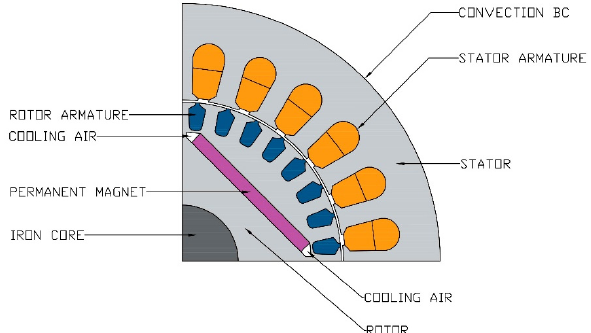
Figure 14. Quarter section of motor illustrating the areas with convection boundary conditions. The temperature distribution in the motor at full load for each voltage harmonic is presented in Figure 15. For the second-order voltage harmonic (Figure 15a), it is observed how the rotor presents the higher temperatures, which, despite the synchronism (zero slip), can be justified by the second- order harmonic component configured at the motor input as well as the new harmonics that appear as a result of the saturation in the ferromagnetic core. Regarding the fifth-order harmonic (Figure 15b), a similar pattern is observed, however, with lower temperatures, which shows that this harmonic is less detrimental to the LSPMM.